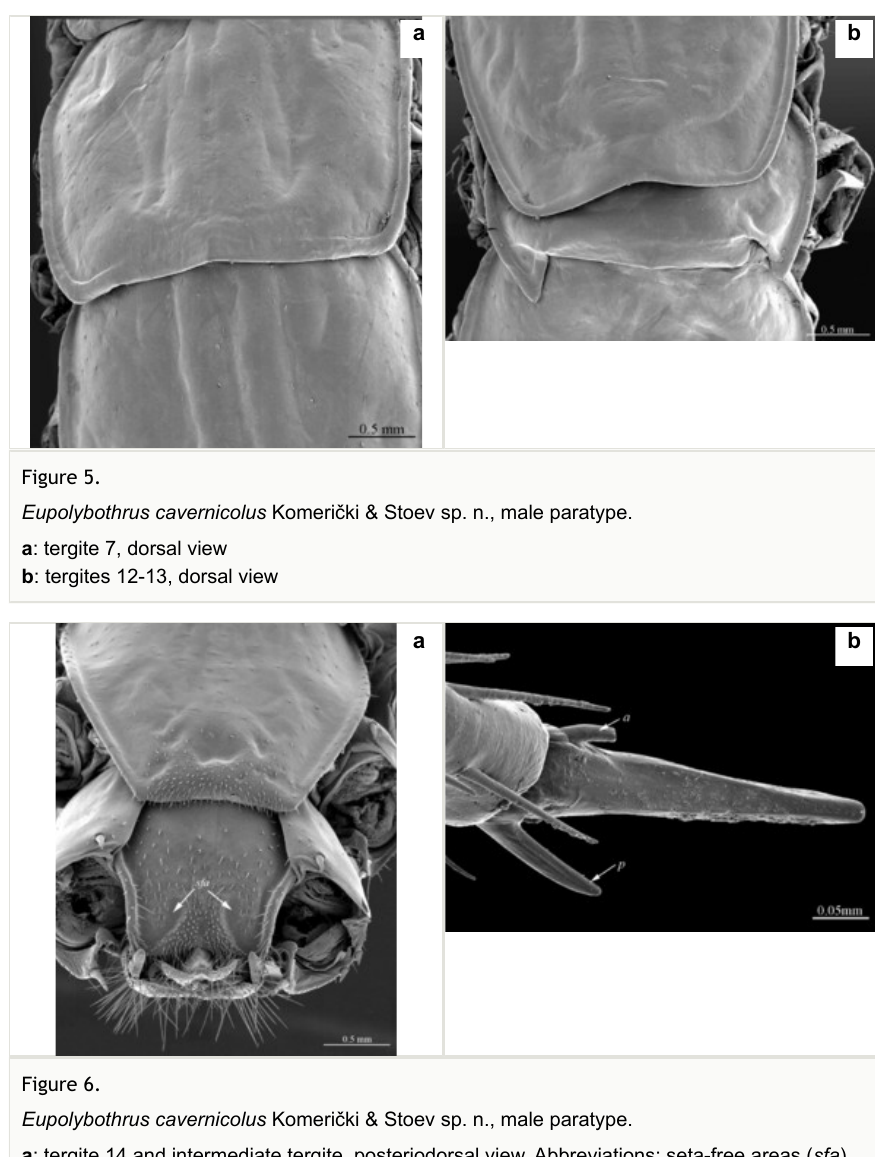
a : tergite 14 and intermediate tergite, posteriodorsal view. Abbreviations: seta-free areas ( sfa ). b : pretarsus of leg 10, ventral view. Abbreviations: anterior accessory claw ( a ), posterior accessory claw ( p